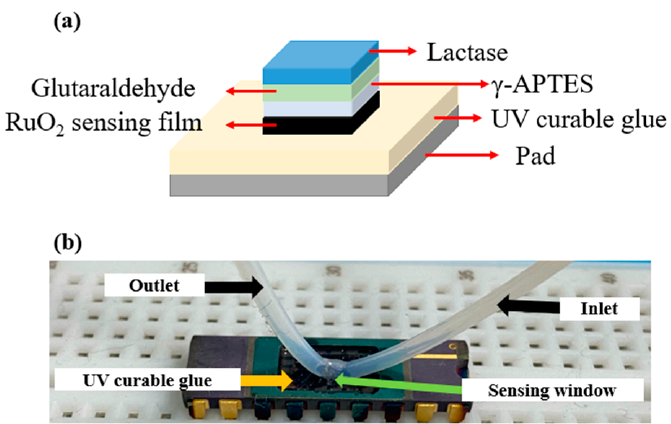
Figure 4. ( a ) The dynamic measurement architecture diagram of EGFET integrated into the OCSW; ( b ) a photo of the dynamic measurement.